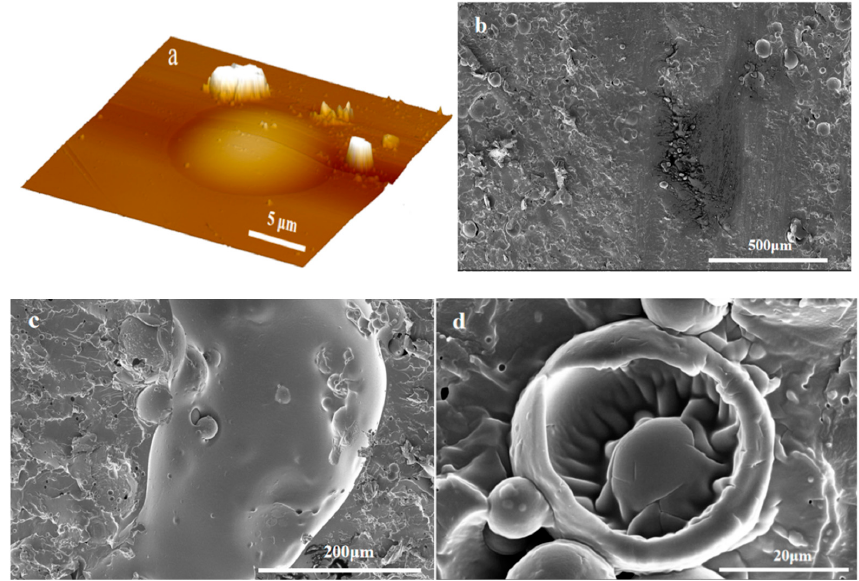
Figure 7. ( a ) AFM images of the surface, and SEM images of the fracture surface, ( b ) before and ( c , d ) after healing for the TO/TMMP-TMTGE self-healing composite.